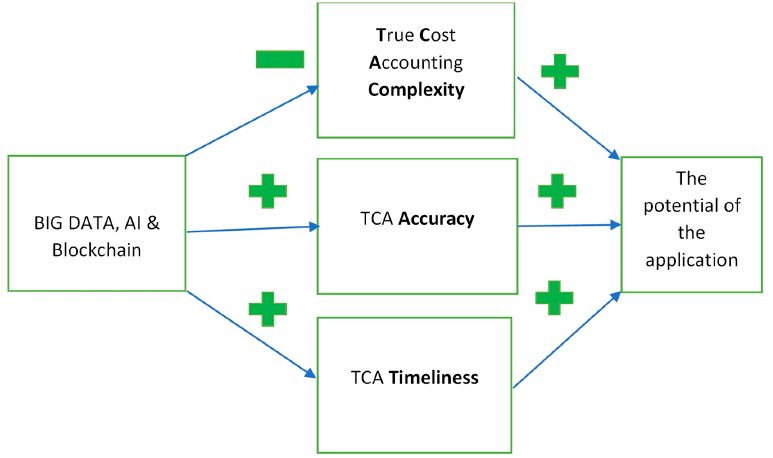
Figure 2. Conceptual model. Source: own study.